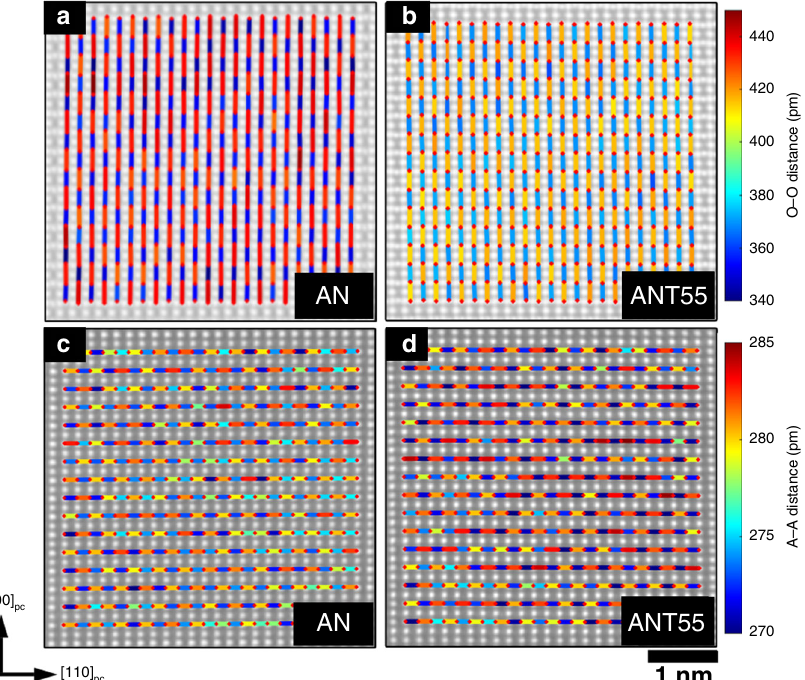
Fig. 6 The oxygen – oxygen and A sublattice cation – cation distances of AN and ANT55 ceramics. Oxygen – oxygen distances in the [100] pc direction for the a AN and b ANT55 samples. A sublattice cation – cation distances in the [110] pc direction for c AN and d ANT55